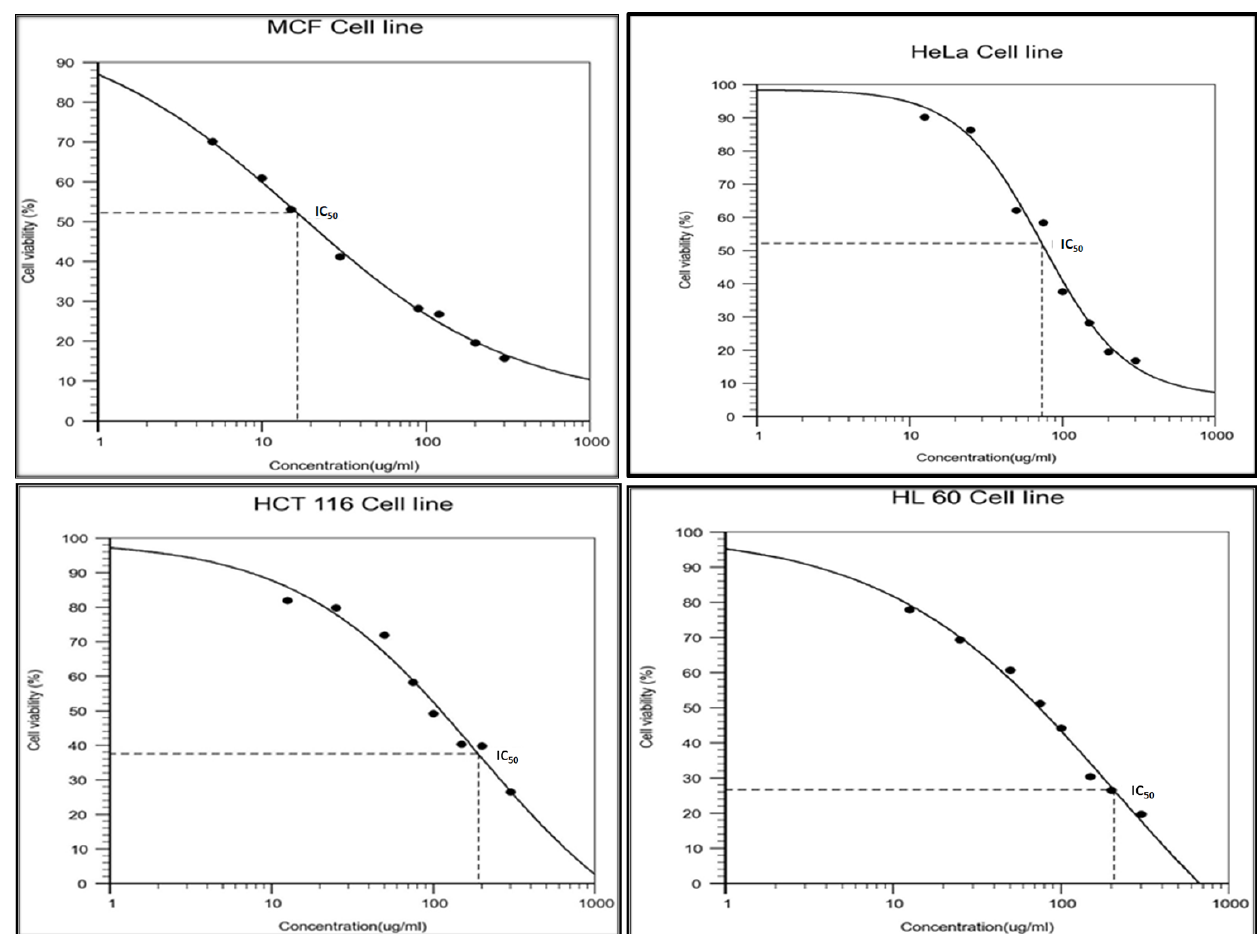
Figure 2. Determination of IC 50 value of crude methanolic extract of Leucas indica flower against selected cancerous cell lines.